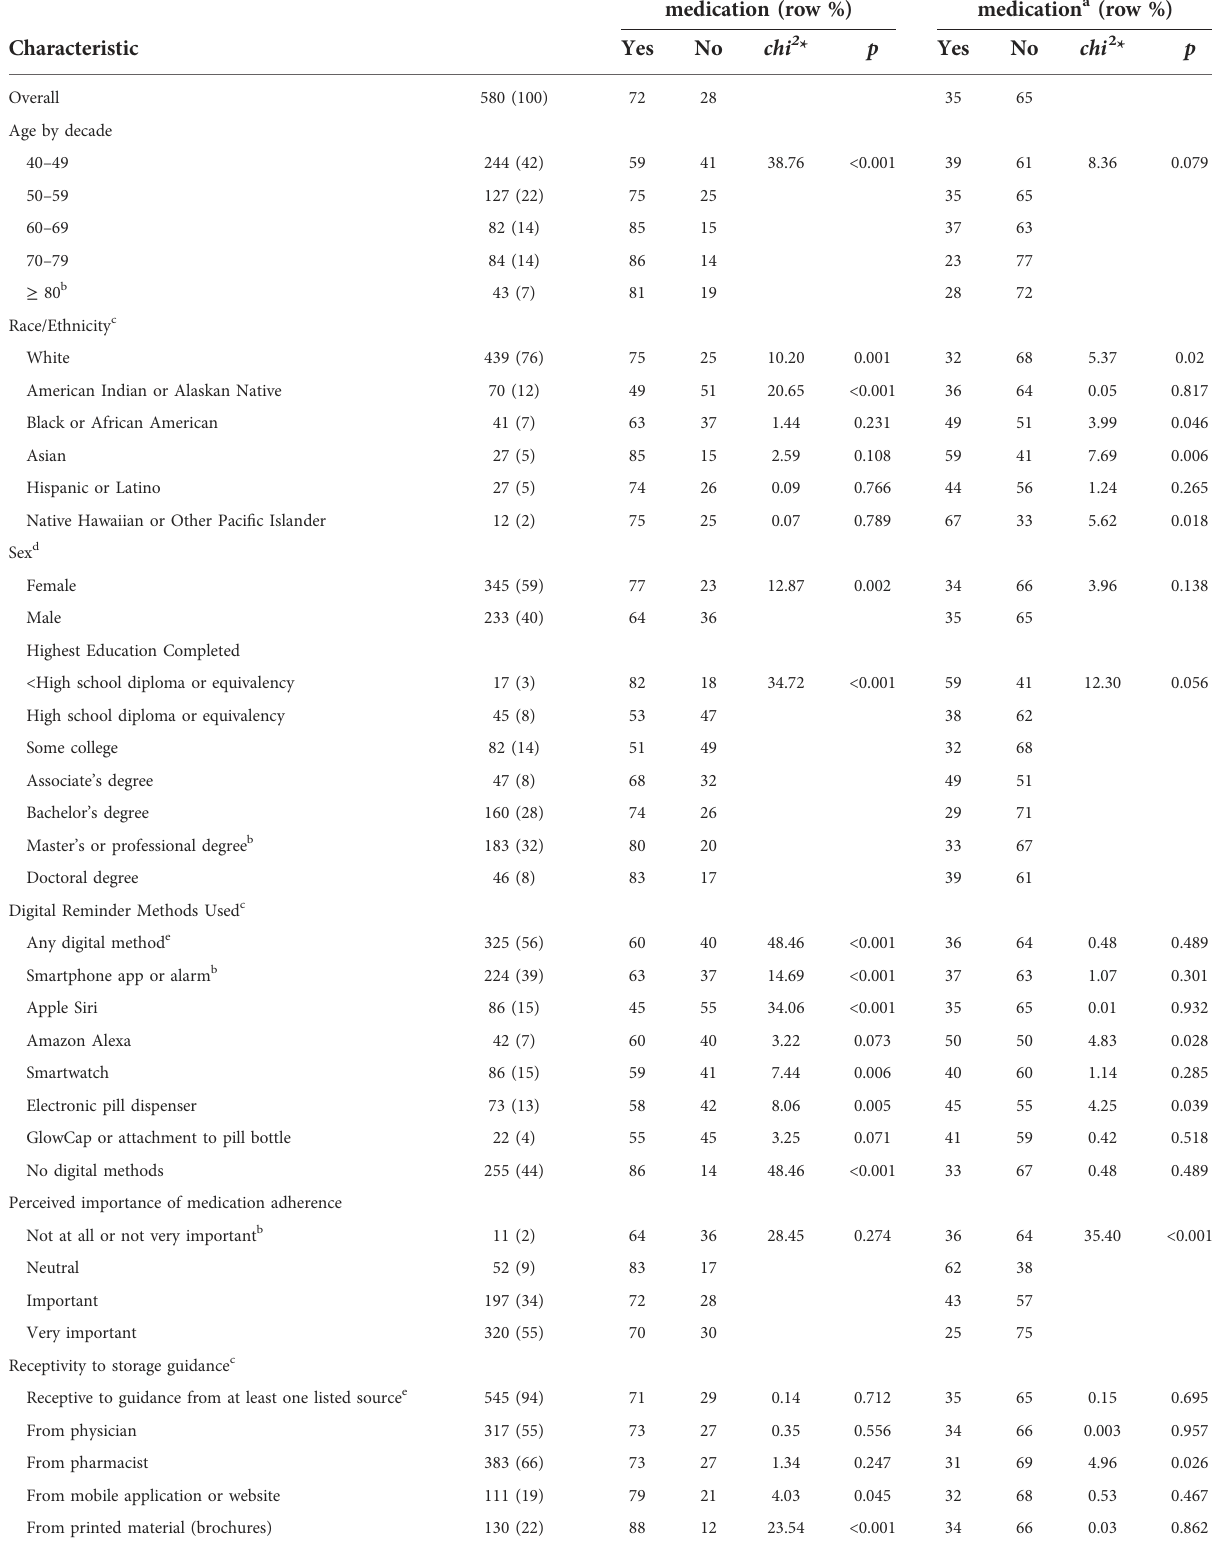
Overall N (%) Ever forgot to take a Recently forgot to take a medication (row %) medication a (row